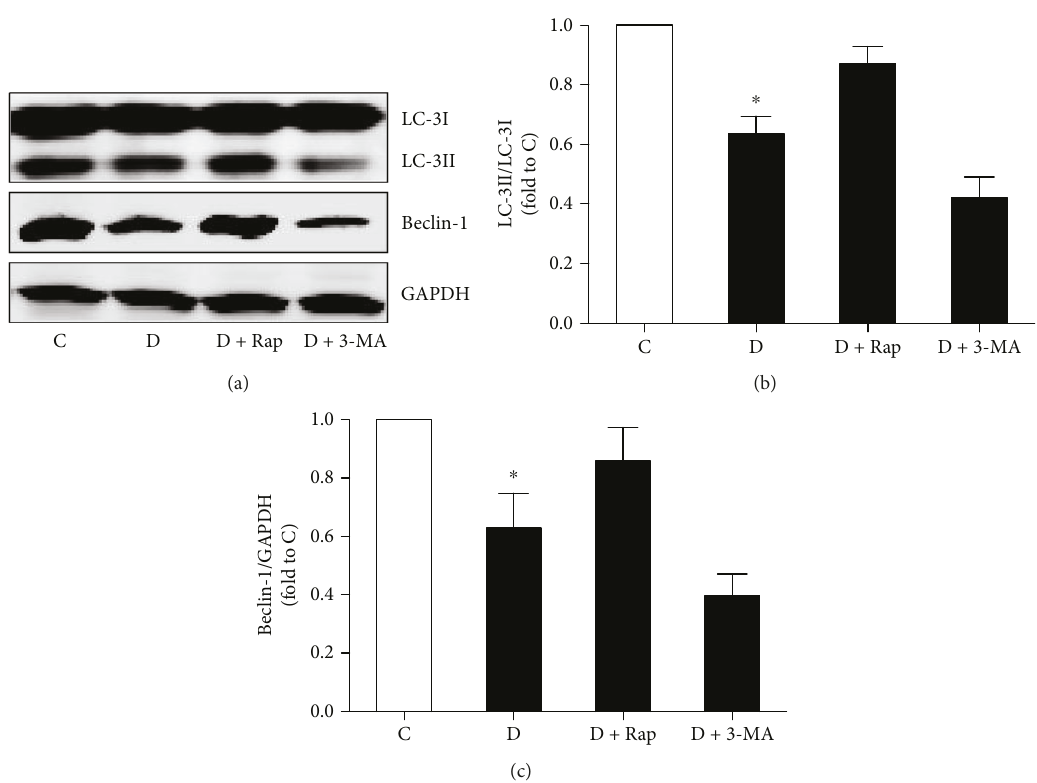
Figure 6: E ff ects of rapamycin (Rap) and 3-methyladenine (3-MA) on the pulmonary expression of LC-3II and Beclin-1 in diabetic rats. Control (C) and diabetic rats (D) pretreated with intraperitoneal 3-MA (15 mg/kg) 30 min or intravenous Rap (0.25 mg/kg) 15min before ischemia or equal volume of saline were subjected to 30min of myocardial ischemia followed by 2h of reperfusion. (a) Representative Western blot demonstrating LC-3II, LC-3I, and Beclin-1 expression with GAPDH as loading control. (b) LC-3II/LC-3I ratio was calculated by relative densitometric values and expressed as fold to C group. (c) Beclin-1 express was calculated by relative densitometric values and expressed as fold to C group. All values are expressed as mean means ± S.D., n = 8 . ∗ P < 0 05 versus the other